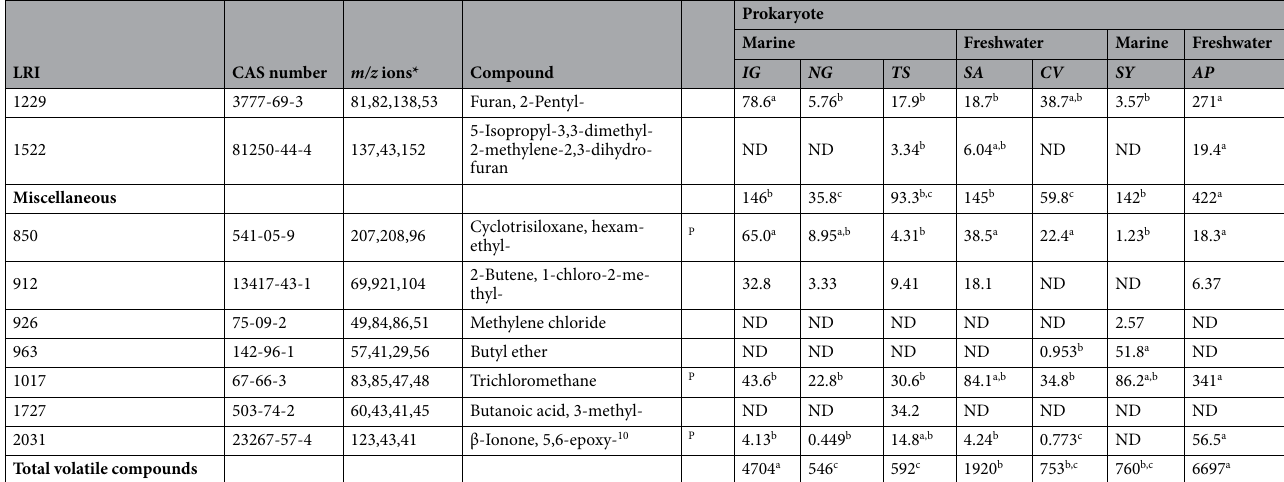
Table 1. Relative abundance (arbitrary area units × 10 3 ) of volatile compounds in Isochrysis galbana (IG) , Nannochloropsis gaditana (NG), Tetraselmis sp. (TS), Scenedesmus almeriensis (SA) , Chlorella vulgaris (CV) Synechococcus sp. ( SY ) and Arthrospira platensis ( AP ) classified by domain (eukaryote- microalgae and prokaryote-cyanobacteria) and environment (marine and freshwater). LRI linear retention index, ND not detected. *Ions selected for quantification; P positive identification with pure standards; a,b,c,d Means with different superscripts indicate statistically significant (P ≤ 0.05) differences among strains. 1 1-cyclohexene-1-carboxaldehyde, 2,6,6-trimethyl-; 2 1,3-cyclohexadiene-1-carboxaldehyde, 2,6,6-trimethyl-;